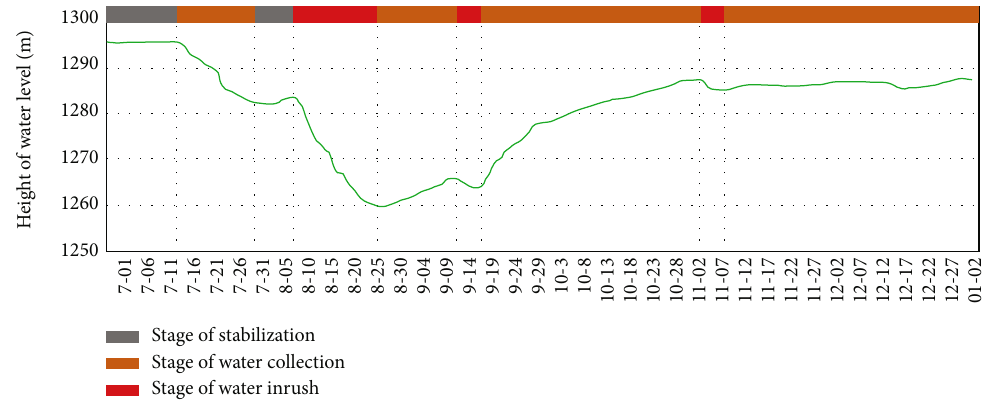
Figure 10: Water level change map of Z1 hydrological observation hole in #111084 working